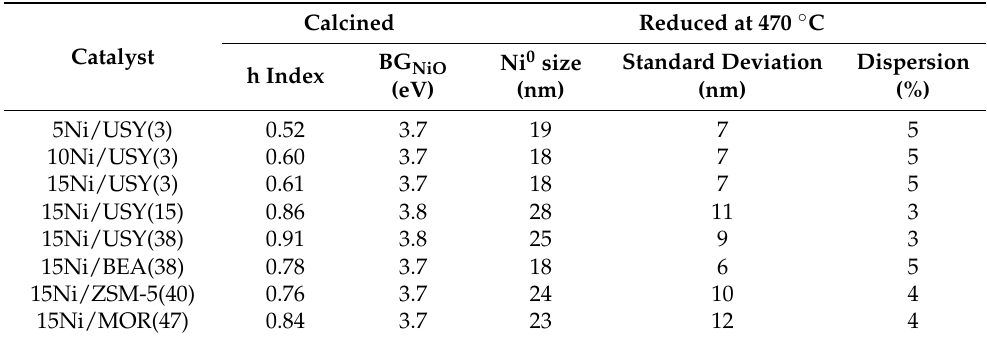
Table 3. h indexes (from TGA-DSC), NiO band gaps (BG; from DRS UV-Vis), Ni 0 average sizes and dispersions (from TEM) obtained for all the samples from the present work.